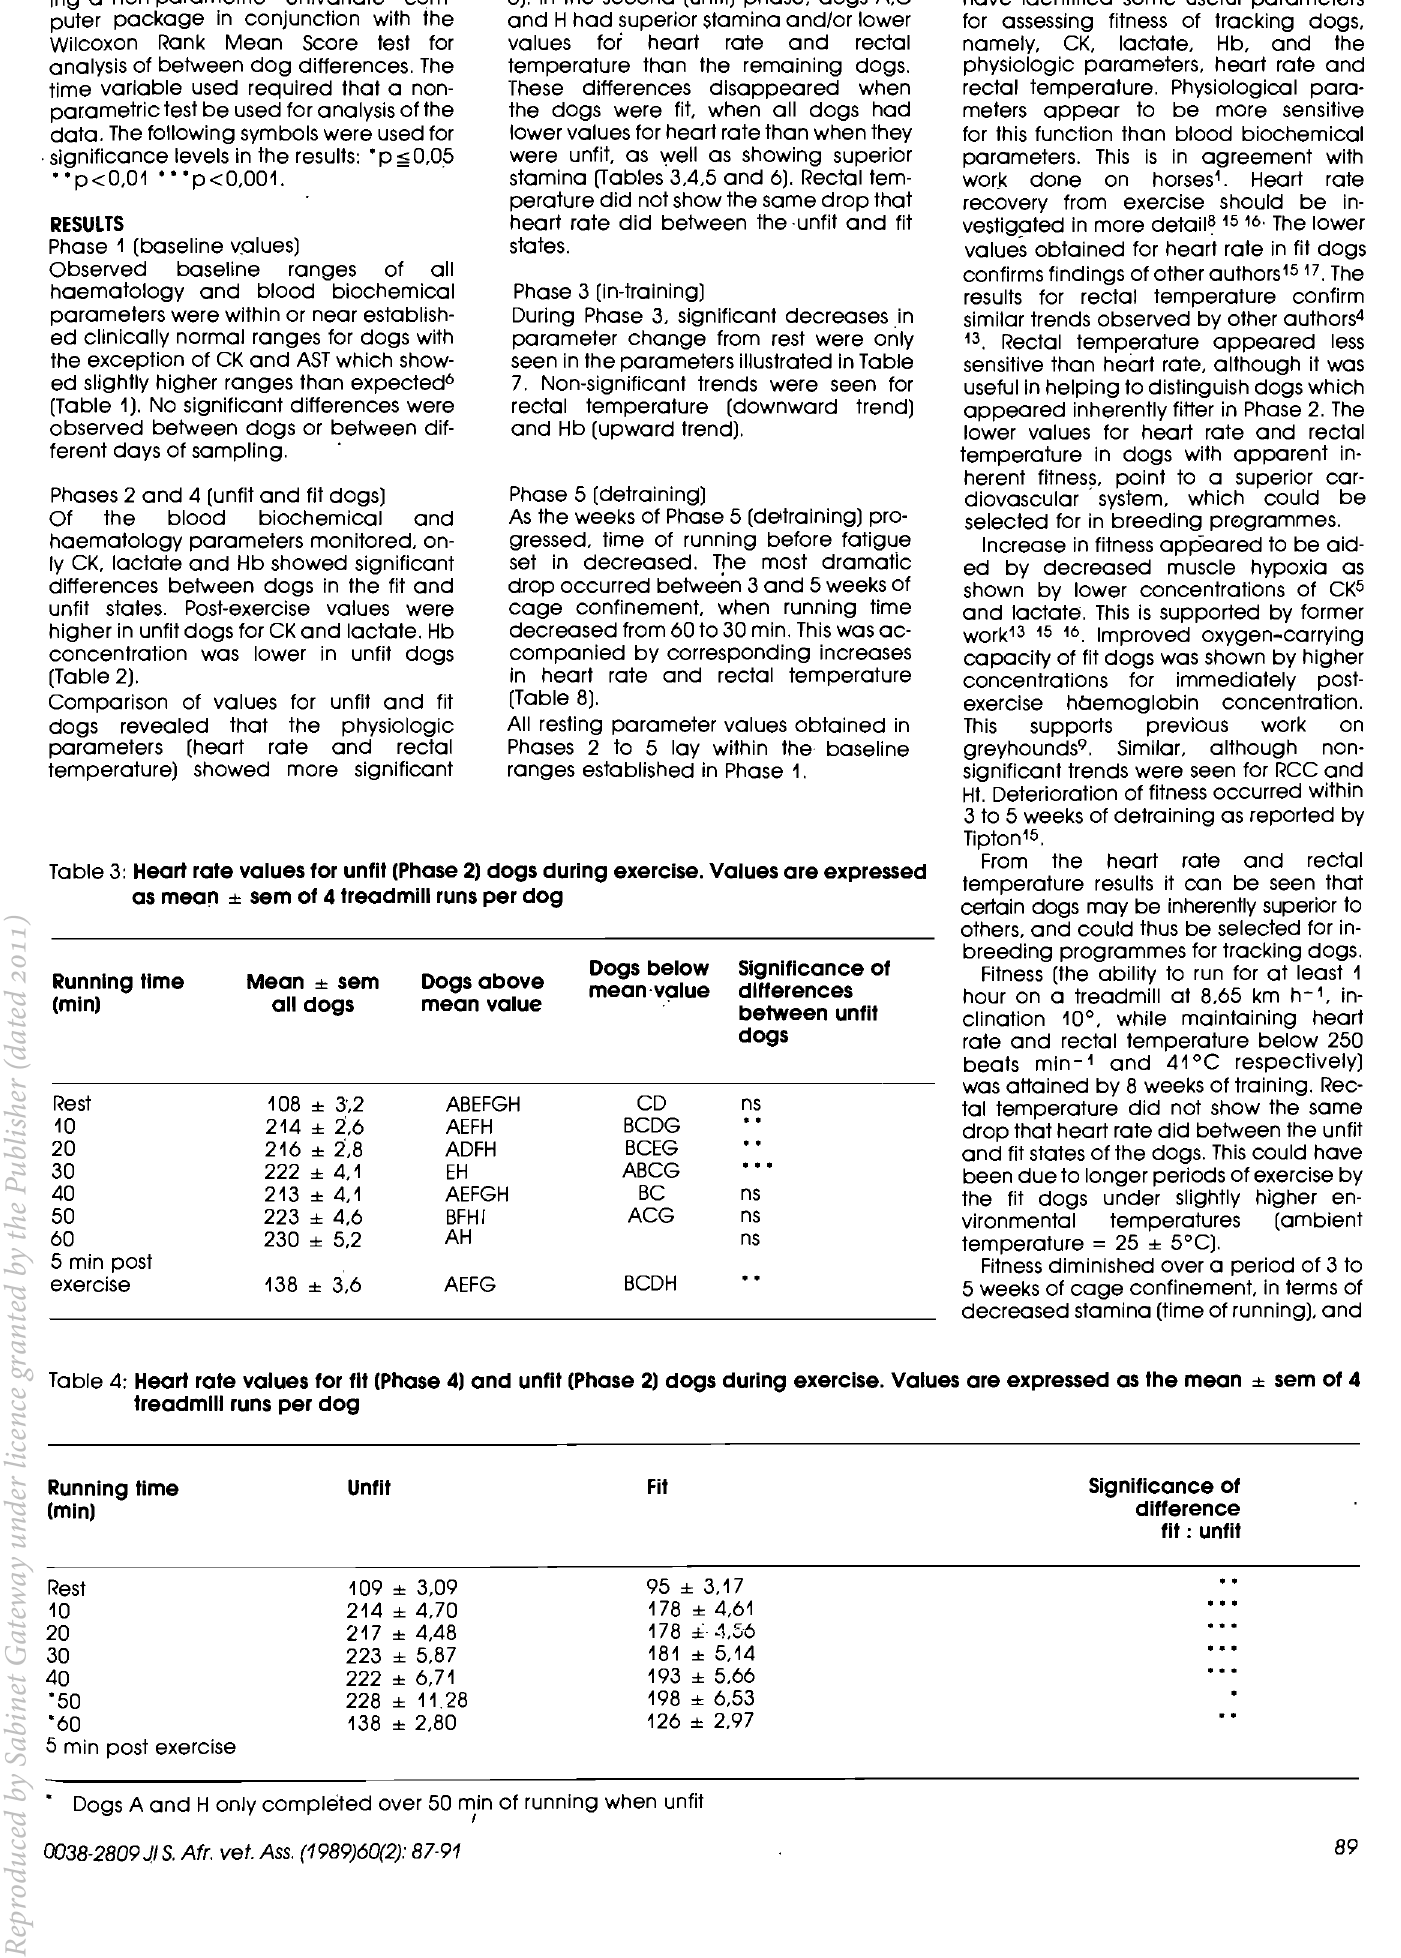
Table 4: Heart rate values for fit (Phase 4) and unfit (Phase 2) dogs during exercise. Values are expressed as the mean ± sem of 4 treadmill runs per dog